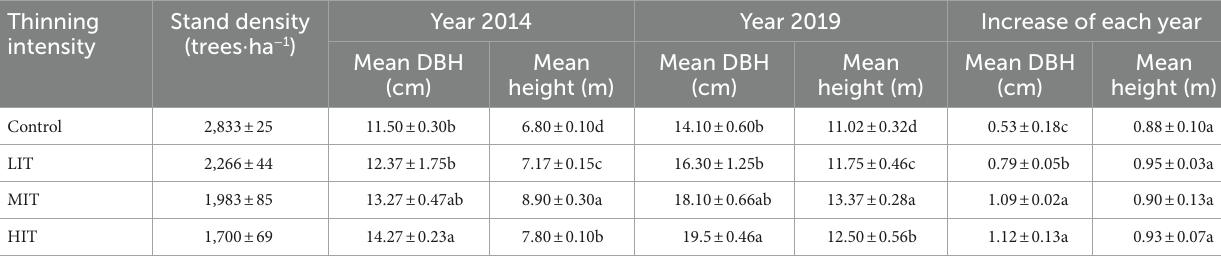
TABLE 1 Information on the thinning trial plantation. Thinning